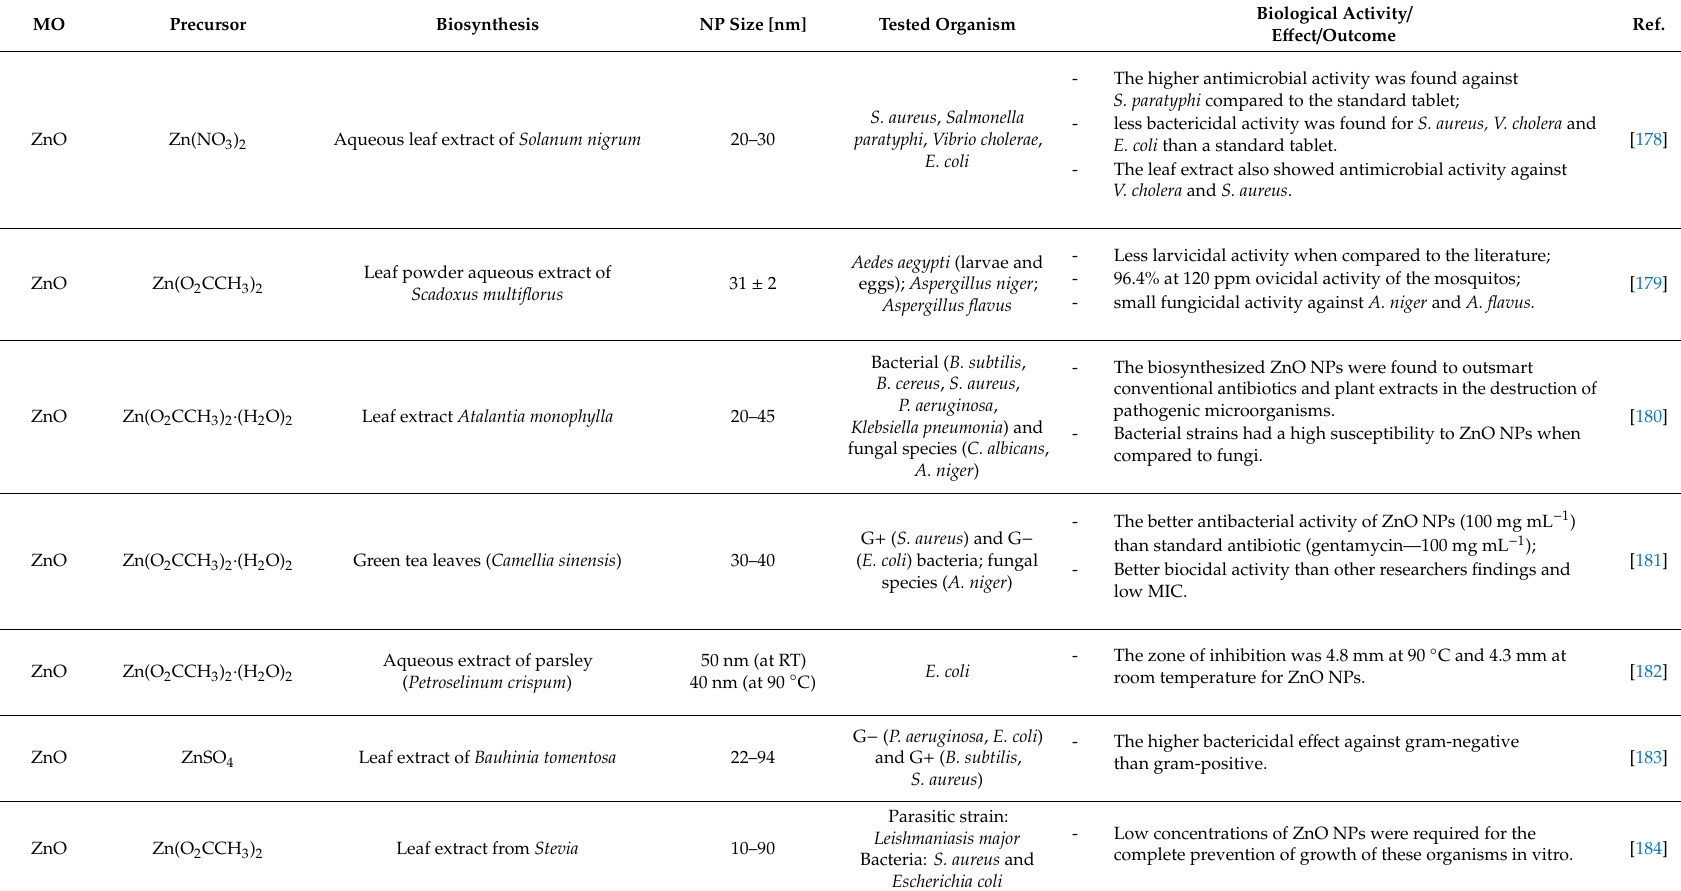
Parasitic strain: Leishmaniasis major